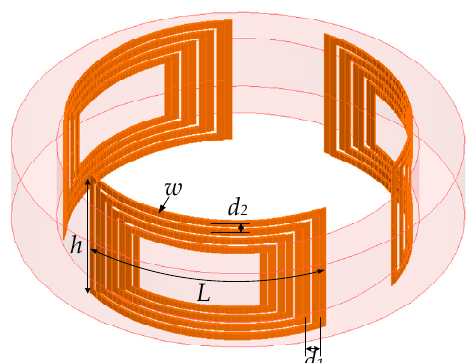
Figure 5. RF coil model. The arc length of each arc spiral coil with N turns is L , the width of wire is w , the height of wire is h , and the spacing of the adjacent wires along the circumference and z -direction is d 1 and d 2 , correspondingly.